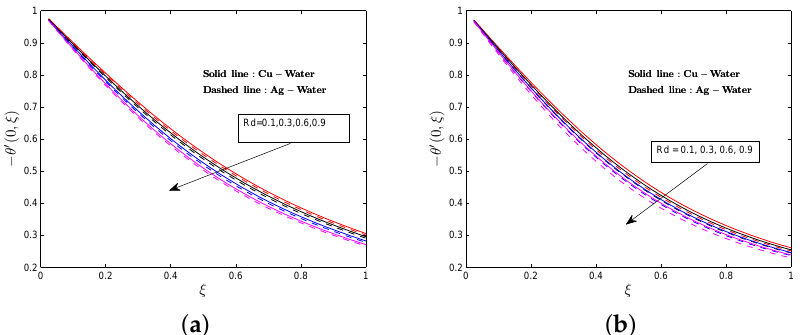
Figure 19. Heat transfer rate for various values of Rd . ( a ) vertical plate; ( b ) horizontal plate.